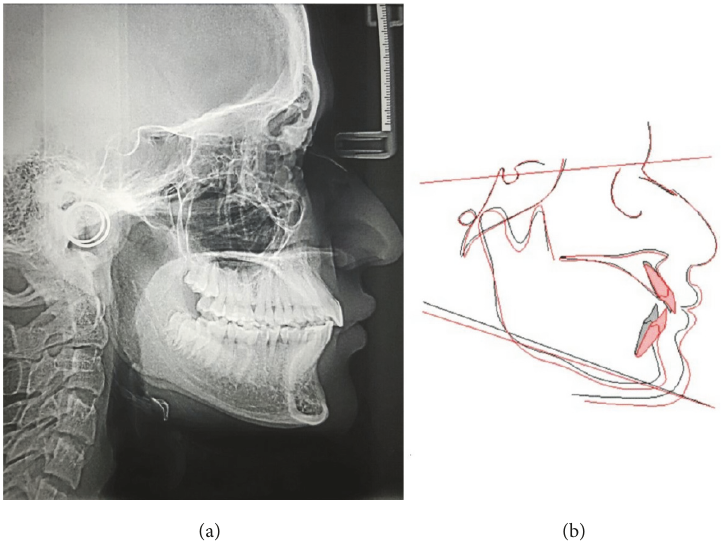
Figure 8: Posttreatment cephalographic image (a); overall superimposition of pretreatment (black color) and posttreatment (red color) cephalometric radiographs